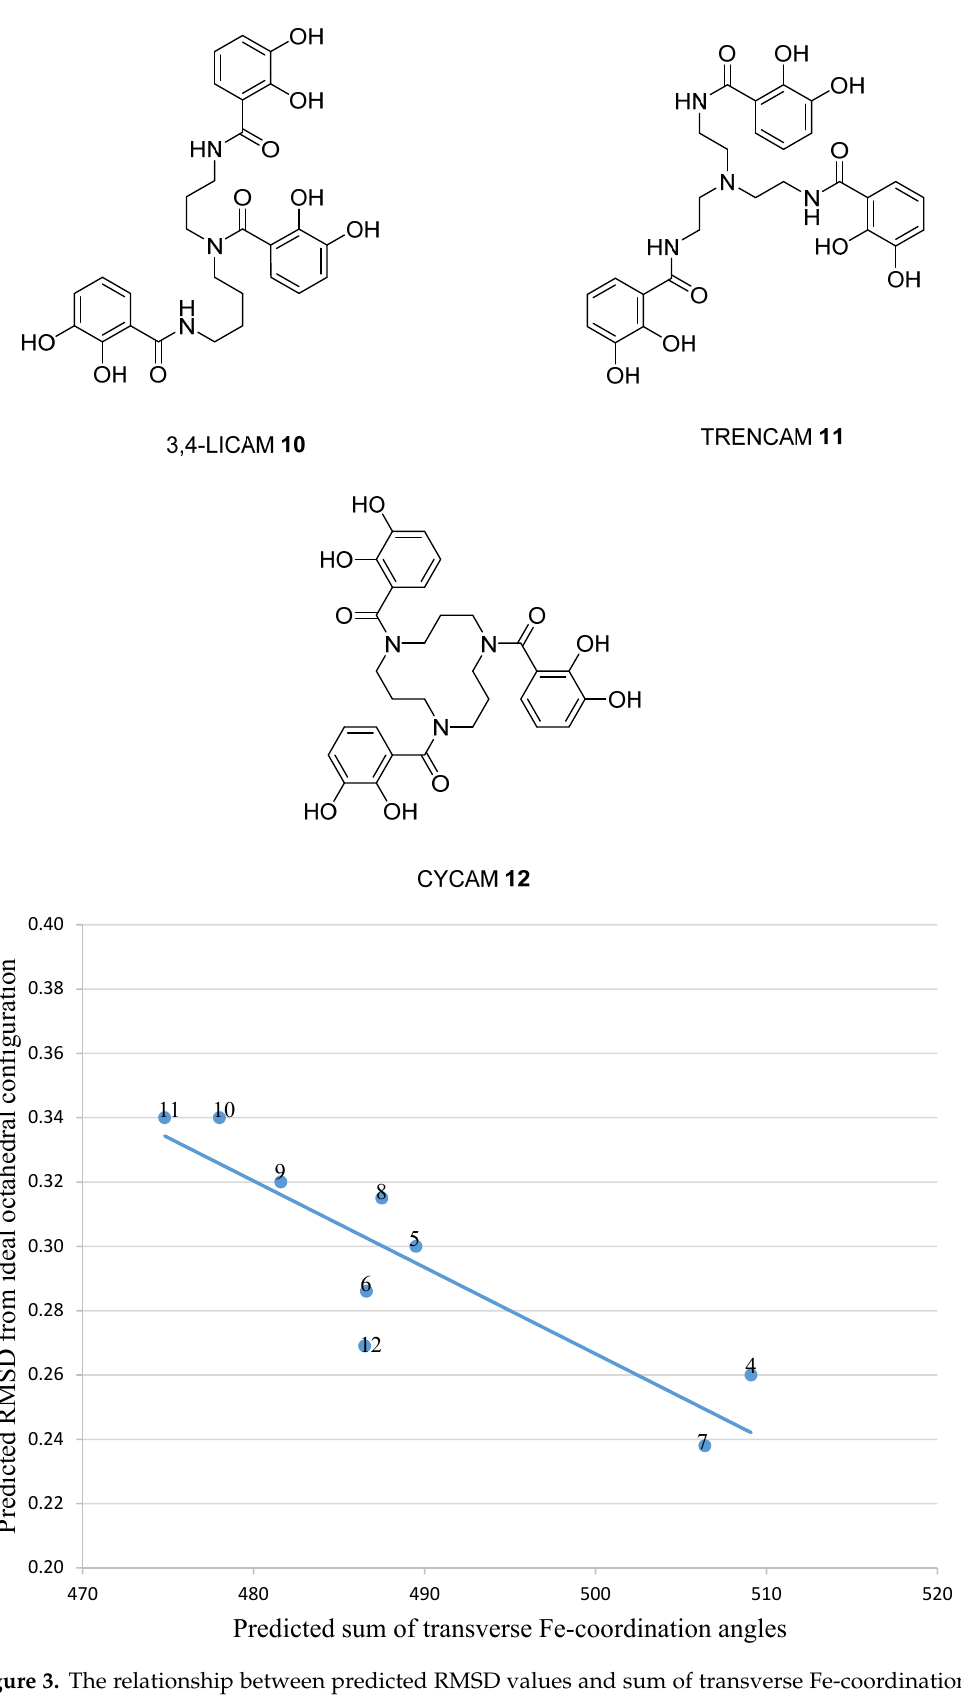
Figure 3. The relationship between predicted RMSD values and sum of transverse Fe-coordination angles for a series of siderophores and siderophore analogues.